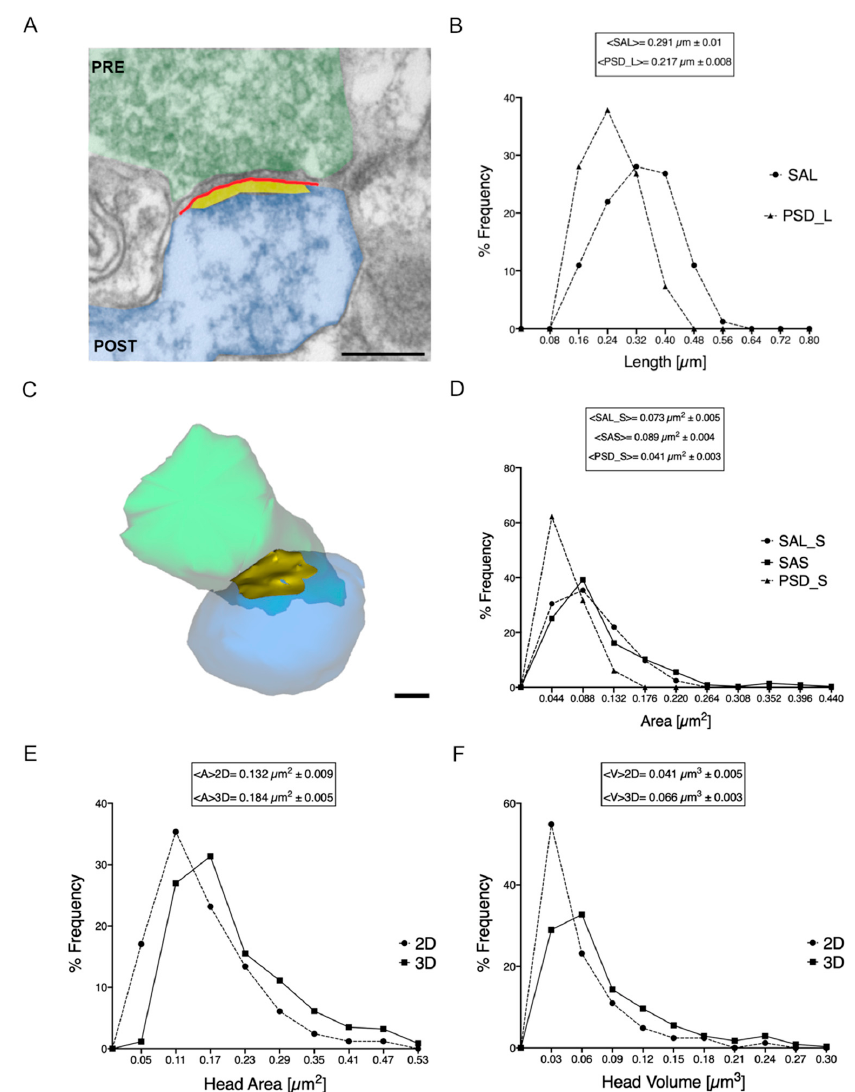
Figure 3. Comparative analyses of spine head area and volume, SAS and SAL between the measures obtained on 2D and 3D data-sets. ( A ) Representative excitatory synapses from 2D TEM image. The pre- and post-synaptic compartments are highlighted in green and blue respectively. The yellow region represents the PSD, whereas the red line represents the synaptic apposition length (SAL), see text. (scale bar = 200 nm); ( B ) Distribution curves of the SAL (dashed line-circles; <SAL> = 0.291 µ m ± 0.010) and PSD length (dashed line-triangles; <PSD_L> = 0.217 µ m ± 0.008) measured and calculated in 2D TEM micrographs; ( C ) Representative excitatory synapses from 3D reconstruction. The pre- and post-synaptic compartments are highlighted in green and blue respectively. The synaptic apposition surface (SAS) can be visualized, in yellow, as a shell shaped structure (scale bar = 100 nm); ( D ) Distribution curves of the SAS (continuous line-squares; <SAS> = 0.089 µ m 2 ± 0.004), SAL_S (dashed line-circles; <SAL_S> = 0.073 µ m 2 ± 0.005) and PSD_S (dashed line-triangles; <PSD_S> = 0.041 µ m 2 ± 0.003) are presented; ( E , F ) Distribution curves of areas and volumes of the spine heads measured and extracted in 2D and 3D as detailed in Materials and Methods. The curves have been generated through the partitioning of spine heads area and volume into 9 and 10 classes of frequency, respectively. The curve of the area measured in 2D (dashed line; <A> 2D = 0.132 µ m 2 ± 0.009) and the one calculated from 3D volumes (continuous line; <A> 3D = 0.184 µ m 2 ± 0.005) are reported in ( E ). Similarly, for spine head volume, the distribution curve of volumes calculated from 2D (dashed line; <V> 2D = 0.041 µ m 3 ± 0.005) and the one of volumes measured in 3D (continuous line; <V> 3D = 0.066 µ m 3 ± 0.003) are reported in ( F ). All data are reported as the mean value ± S.E.M.; these values derive from the analysis of more than 80 dendritic spines from 2D TEM sections and more than 340 spines segmented and reconstructed into 3D objects from samples of mouse CA1